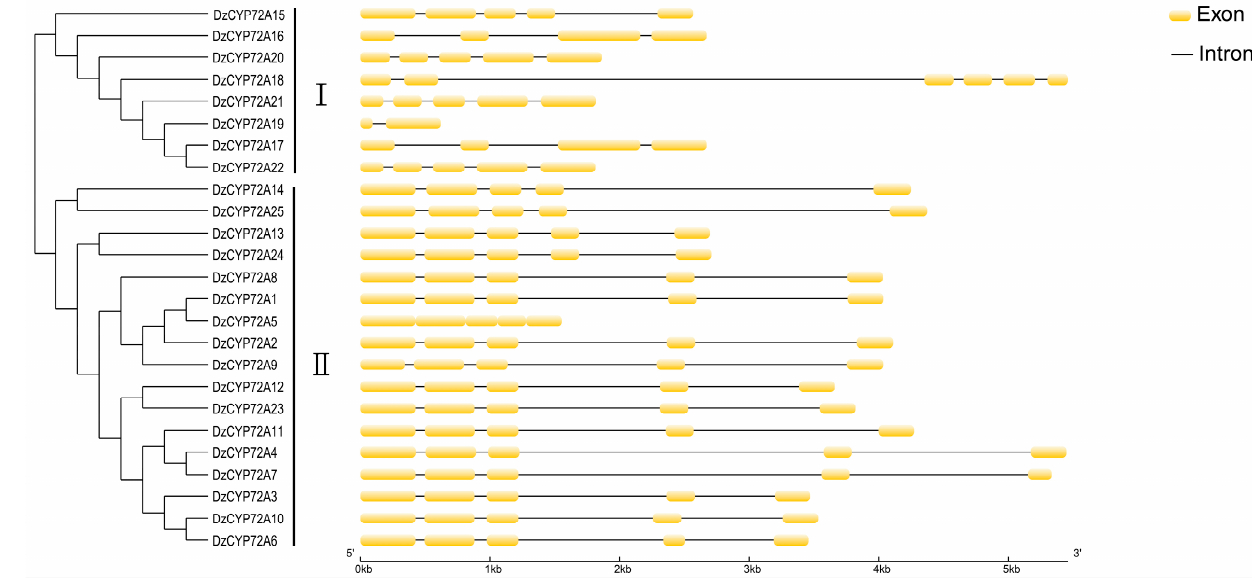
Figure 3. Gene structure of DzCYP72As .